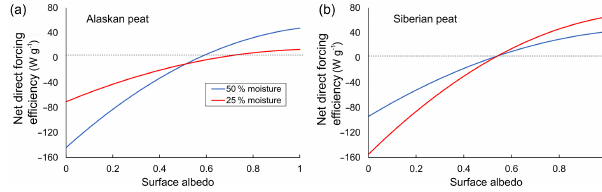
Figure 5. Net direct forcing efficiencies as a function of surface albedo for Alaskan and Siberian peat smoke aerosols. The crossover from negative (cooling) to positive (warming) values takes place between surface albedo values of